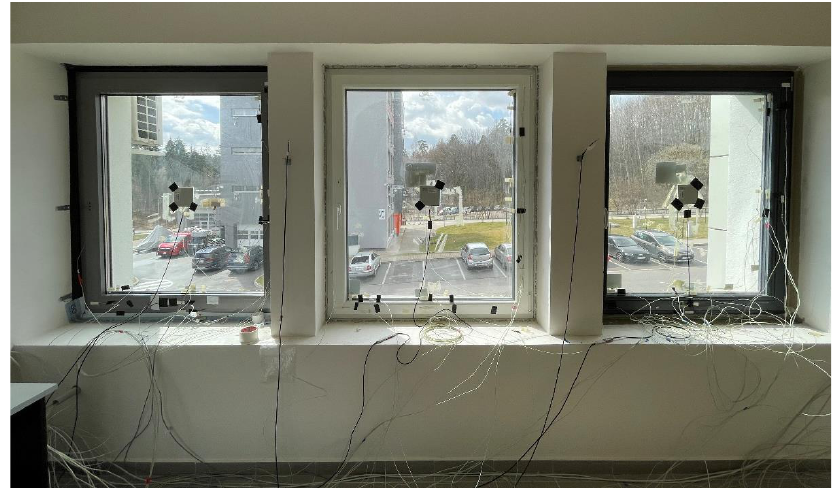
Figure 2. Window constructions were installed in the pavilion laboratory.